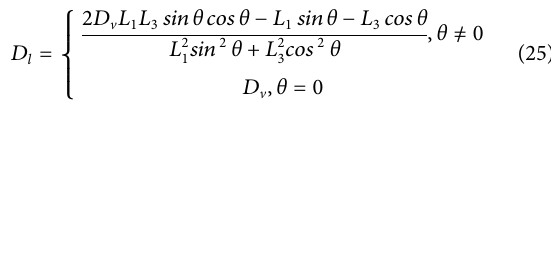
Frontiers in Earth